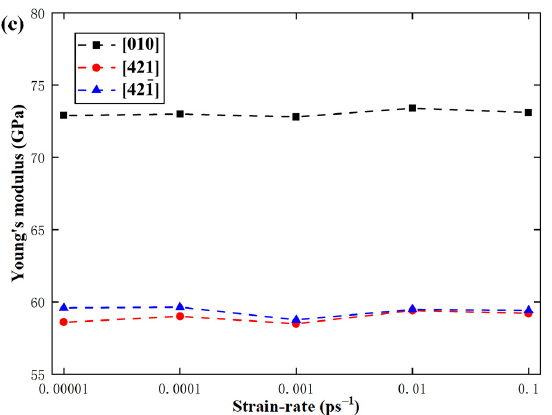
Figure 13. Variations of ( a ) fracture strength, ( b ) fracture strain, and ( c ) elastic modulus with strain rate.